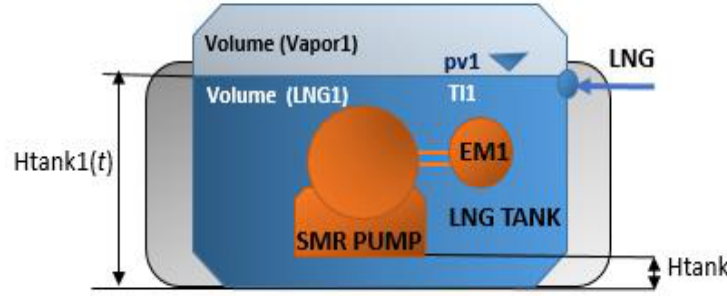
Figure 3. LNG level observation in the LNG tank.